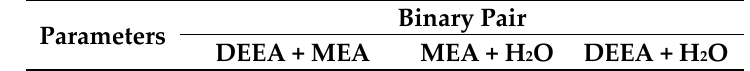
Table 16. Binary parameters 𝐴 0 , 𝐴 1 , and 𝐴 2 of the equation Δ𝐺 𝑗𝑘𝐸∗ = 𝑥 𝑗 𝑥 𝑘 ∑ 𝐴 𝑖 (𝑥 𝑗 − 𝑥 𝑘 ) excess free energy of activation for the viscous flow of DEEA (1) + MEA (2) + H 2 O